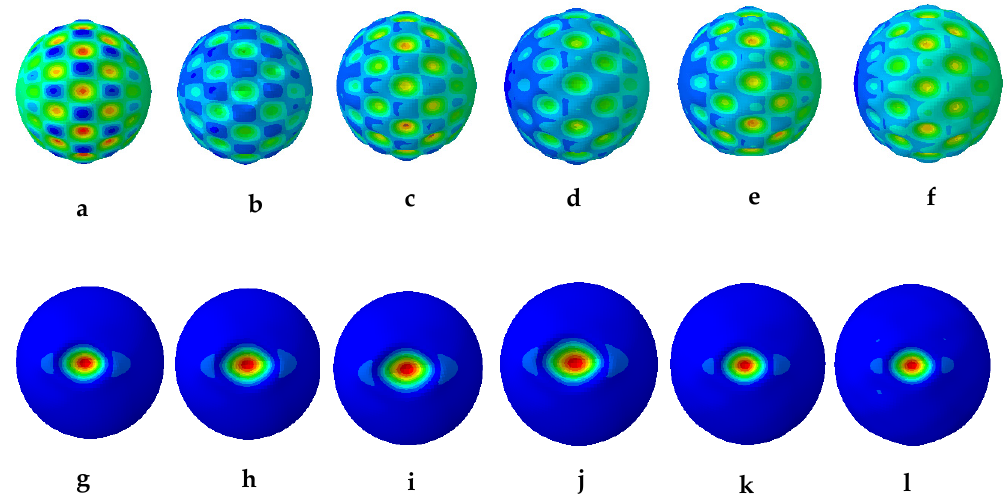
Figure 7. Critical buckling modes ( a – f ) and post-buckling modes ( g – l ) of the spherical composite pressure hull for 1 mm, 2 mm, 3 mm, 4 mm, 5 mm, and 10 mm size of imperfections in the case of lowest buckling mode imperfection.